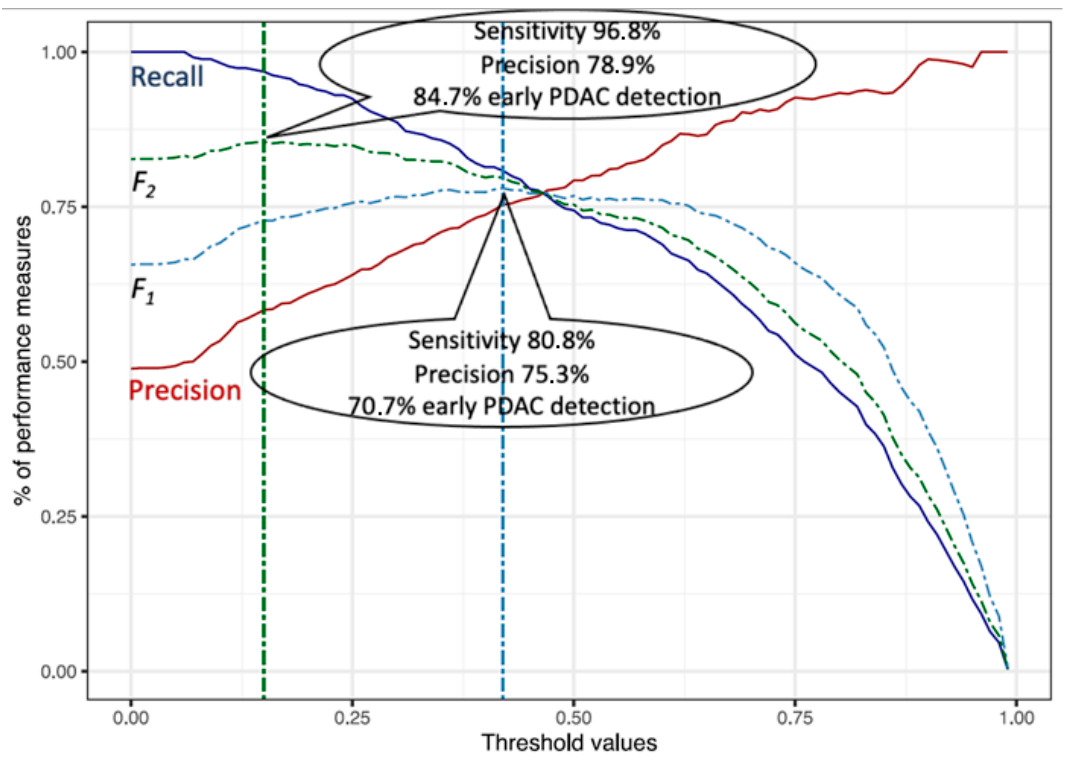
Figure 4. A performance measure graph of the LR ‐ StepAIC model, with the resultant performance of the model at maximum F 1 and F 2 ‐ scores on the full dataset. The percentage of early PDAC detection includes the use of an 87.5% sensitive biomarker.